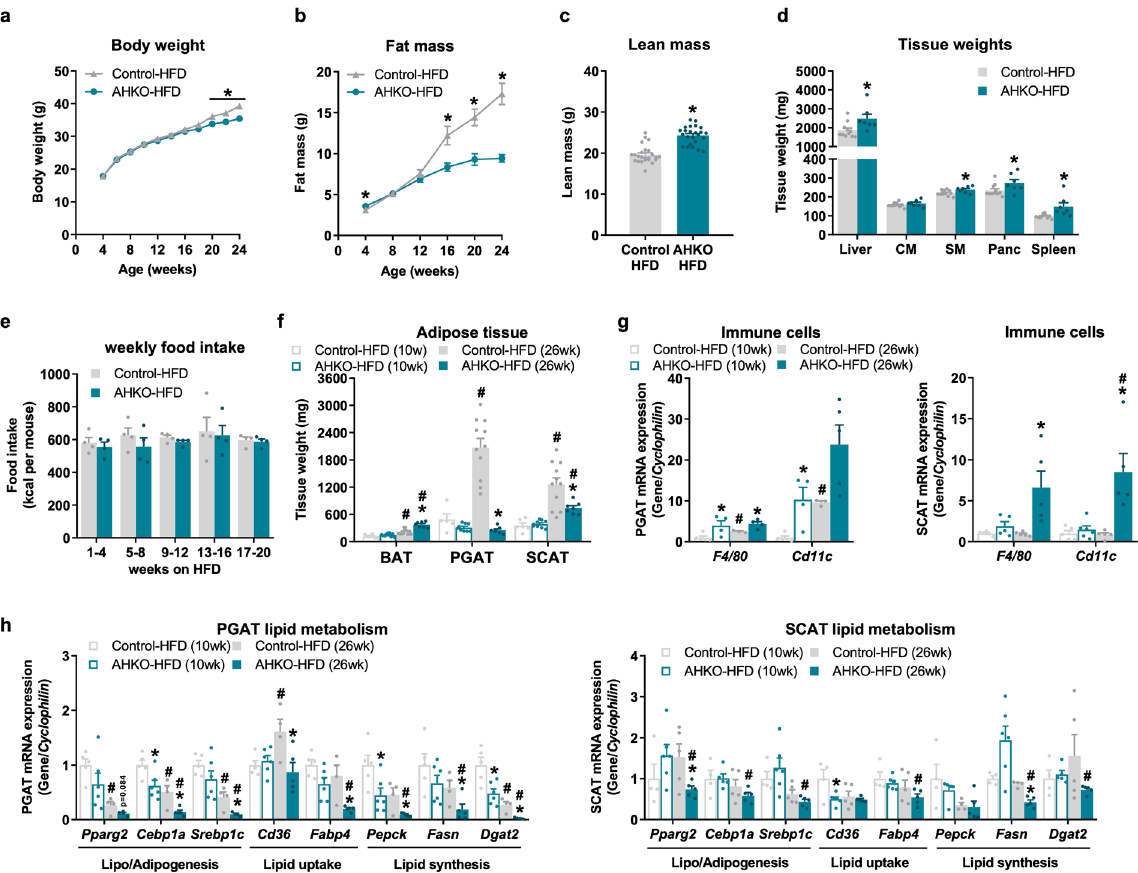
Fig. 2 Effects of adipocyte-speci fi c HSL deletion on systemic energy homeostasis and adipose tissue phenotype in HFD-fed mice. a Longitudinal body weight and b fat mass in control and AHKO mice fed HFD (M, 4 – 24 weeks, ad libitum fed, n = 9 – 25 animals/genotype). c Lean mass (M, 24 weeks,